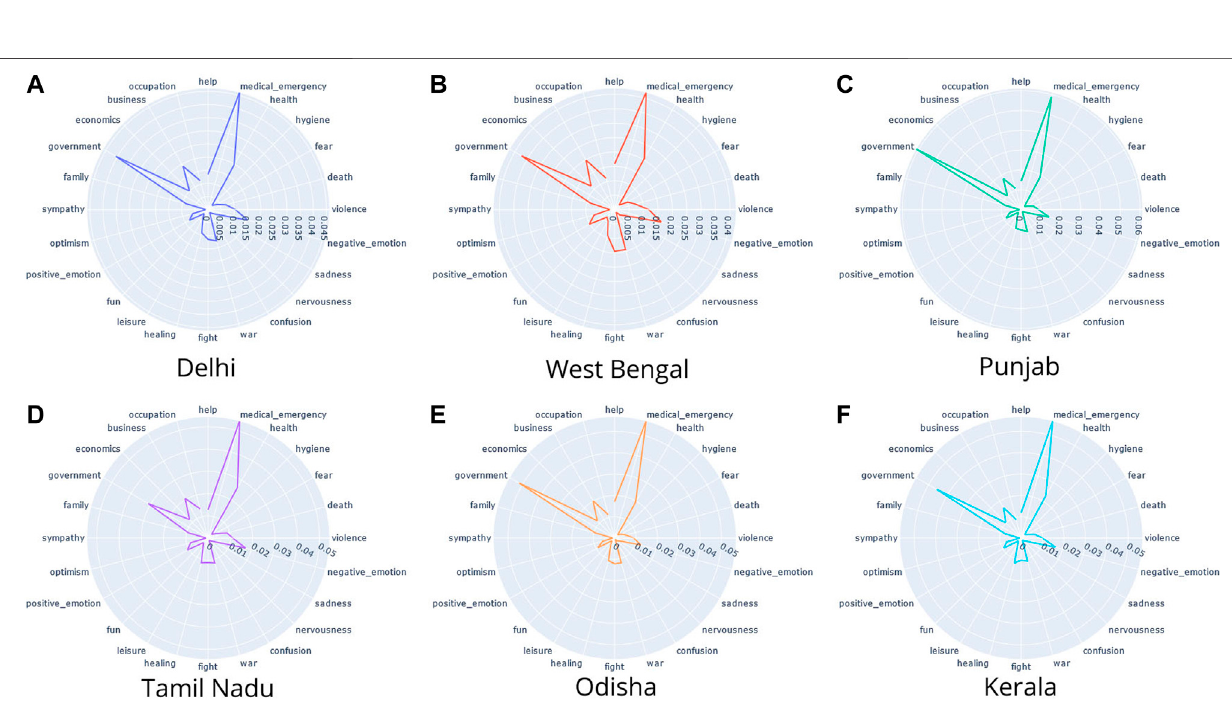
Frontiers in Communication |